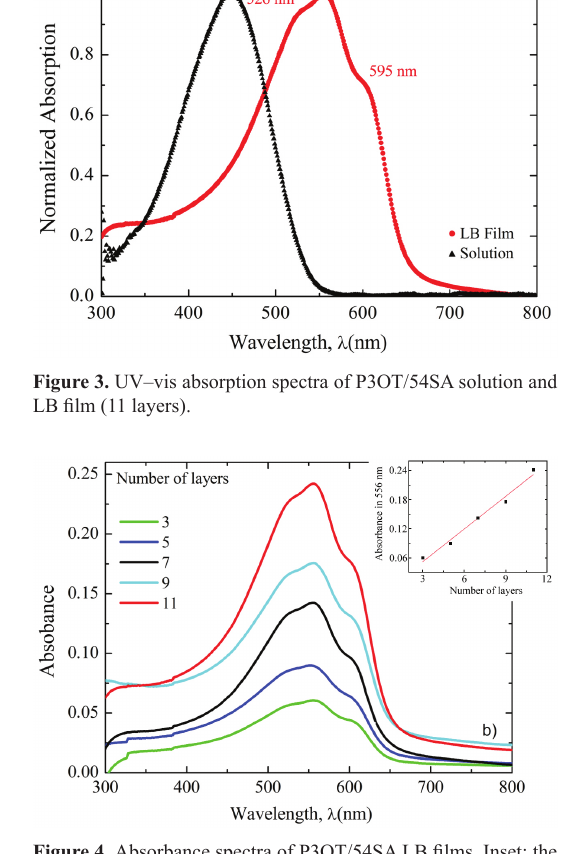
Figure 4. Absorbance spectra of P3OT/54SA LB films. Inset: the relationship between the absorbance (556 nm) and the number of transferred layers.